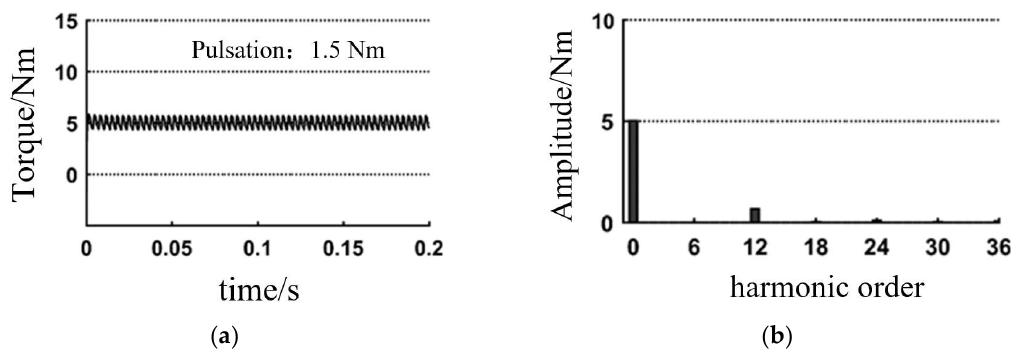
Figure 3. Simulation results without feedforward controller. ( a ) Torque wave; ( b ) Fast Fourier transform (FFT) analysis of torque wave.